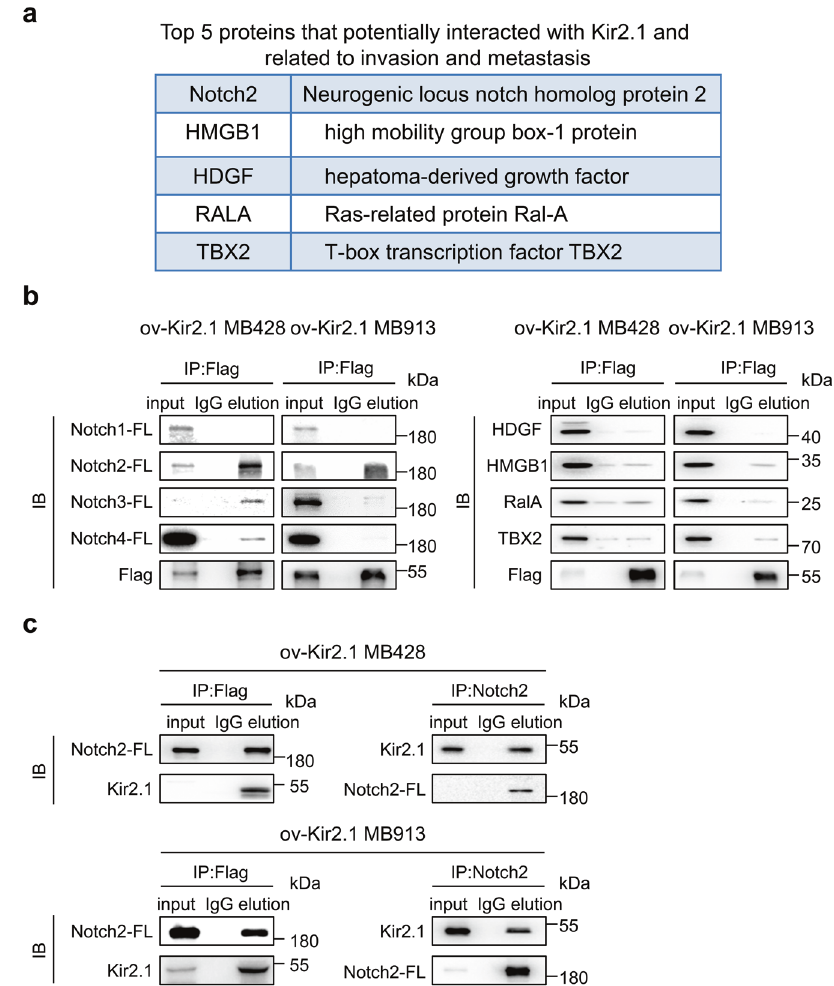
Fig. 3 Kir2.1 physically interacts with Notch2 in non-WNT/SHH MB cells. a Immunoprecipitation-mass spectrometry-predicted top 5 Kir2.1- interacting proteins related to invasion and metastasis in non-WNT/SHH MB cells. b Co-IP showing that Notch2 was physically conjugated with Kir2.1 among the predicated proteins. Since anti-Kir2.1 antibody for IP was unavailable, anti-Flag antibody was used to bind Flag-tagged Kir2.1 in Kir2.1-overexpressing cells. c Co-IP validation of the interaction between Notch2-FL and Kir2.1 in MB428 and MB913 cells cells, in which Kir2.1 was labeled with red fl uorescence while the intracellular domain of Notch2 (N2ICD) was in green. In control MB428 cells, both Kir2.1 and N2ICD were detected mainly in the cell membranes (Fig. 4a, upper panel). However, in Kir2.1- overexpressing MB428 cells, most Notch2 signals were detected in the cytoplasm and nuclei, with the distribution pattern of Kir2.1 unchanged (Fig. 4a, lower panel). It has been known that the maturation and activation of Notch2 include site1 (S1), site2 (S2), and site3 (S3) cleavages. 51 S2 cleavage releases the extracellular domain of Notch2 (N2ECD) from the membrane, and subsequent S3 cleavage generates functional Notch2 intracellular domain (N2ICD), which translocates to the nucleus as a transcription factor. By using an antibody against the extracellular domain of Notch2 (N2ECD), we detected decreased N2ECD in the membrane of Kir2.1-overexpressing MB cells, but an increase in the cell membrane of Kir2.1-knockdown MB cells as compared with paired control cells (Fig. 4b). We then isolated the cytoplasm and nuclei from Kir2.1-overexpression, -knockdown, and control cells to detect N2ICD by Western blotting. Compared to control cells, Kir2.1 overexpression in MB428 and MB913 cells markedly enhanced N2ICD in both cytoplasm and nuclei, while Kir2.1 knockdown signi fi cantly reduced N2ICD in both compartments (Fig. 4c).